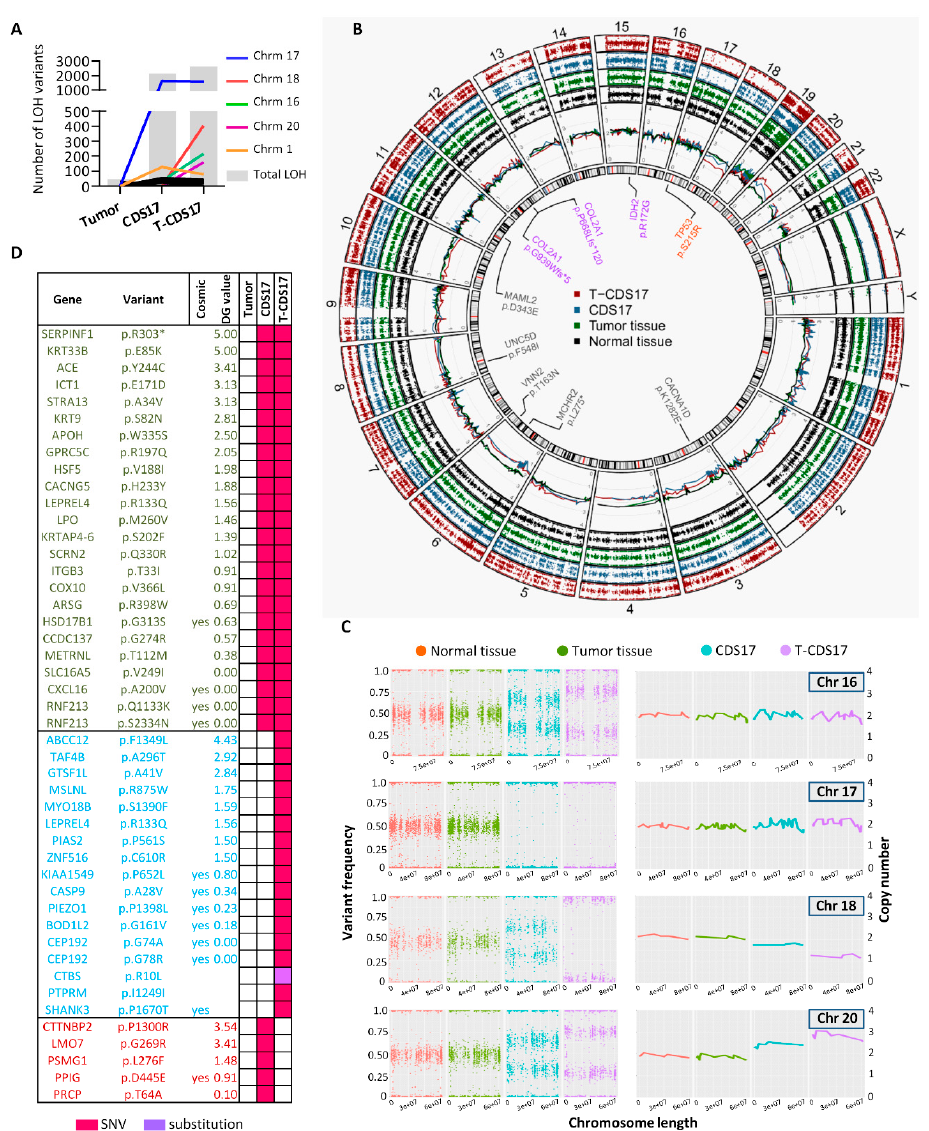
Figure 4. Genomic structural alterations after in vitro and in vivo growth of chondrosarcoma cell lines. ( A ) Number of LOH (total number and distribution between chromosomes) calculated from WES data of tumor, CDS17, and T-CDS17 samples. ( B ) Circular representation of the four samples sequenced through WES. Circles display from the inside outwards: (ring 1) chromosome ideogram, highlighting relevant previously reported (purple) or unreported (grey) somatic variants shared by tumor tissue, CDS17 and T-CDS17, as well as a TP53 homozygous mutation shared by CDS17 and T-CDS17 but not tumor tissue (orange); (ring 2) chromosome copy number (CN) of each sample based on normalized read counts; (rings 3–6) variant frequencies of common polymorphic positions (minimum allele frequency ≥ 0.01 in at least one major dbSNP population) in each sample. ( C ) Analysis of variant frequencies (left panels) and CN (right panels) extracted from ( B ) in the indicated chromosomes. Similar representations for other chromosomes are show in Figure S3B. ( D ) List of T-CDS17 cells. Conversely, a copy of chromosome 20 was gained in subset of CDS17 cells and in the entire population of T-CDS17 cells (Figure 4B,C). Finally, other copy number variations (CNVs) and / or shifts in variant frequencies a ff ecting subpopulations of CDS-17 and / or T-CDS17 cells, was also detected in other chromosomes like 1, 2, 4, 5, 6, or 7 (Figure 4B and Figure